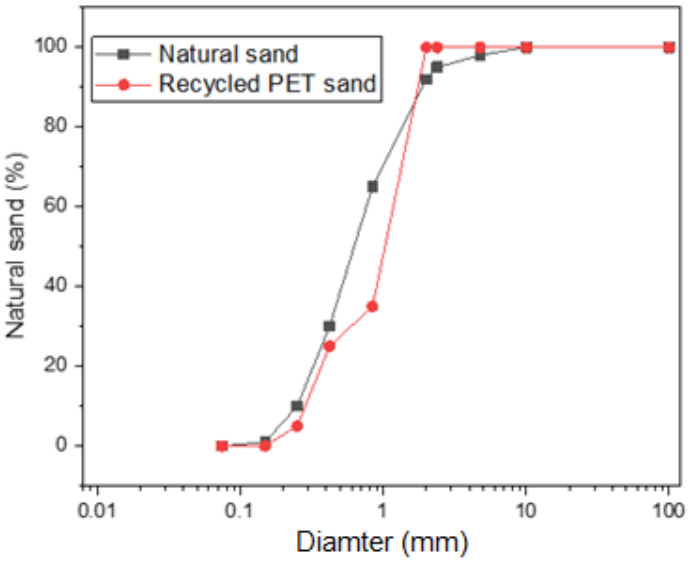
Figure 1. Granulometry of aggregates.